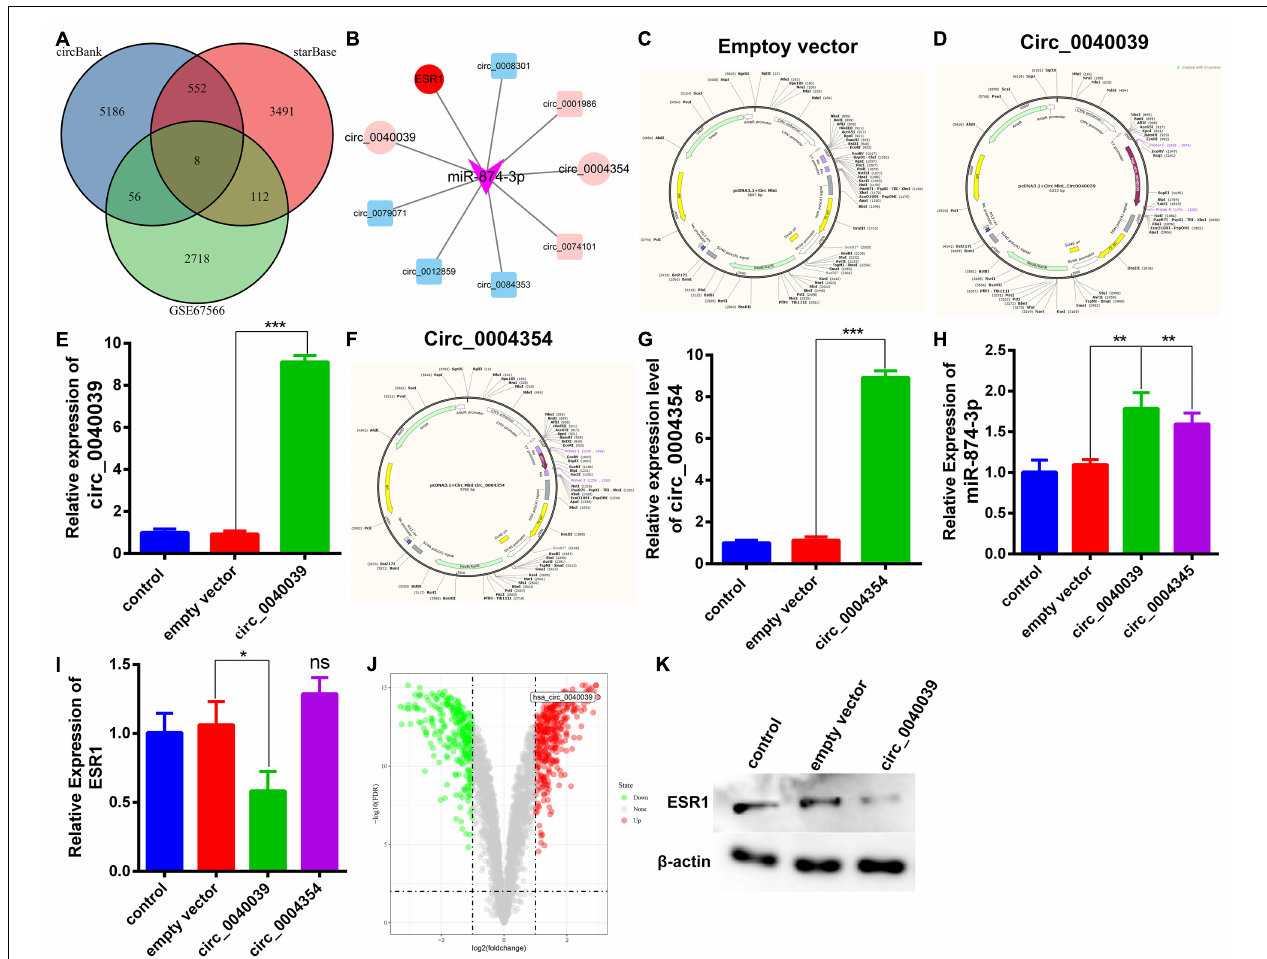
FIGURE 4 | Prediction and verification of the upstream circRNAs of miR-874-3p. (A) Venn diagram was used to select the overlapping upstream circRNAs of miR-874-3p through the intersection of circbank and starBase databases, and the GSE67566 dataset. (B) CircRNAs-miR-874-3p-ESR1 interaction network was established using Cytoscape software. Light red represents upregulated circRNAs, and light green represents downregulated circRNAs. Circ_0040039, circ_0004354, and ESR1 were exhibited with a red ellipse, whereas miR-874-3p was represented by purple triangles. (C) CircRNA empty vector atlas. (D) Circ_0040039 overexpression vector atlas. (E) Overexpression effect of circ_0040039 was validated in NPCs using the qRT-PCR assay. (F) Circ_0004354 overexpression vector atlas. (G) qRT-PCR assay corroborated that the expression of circ_0004354 significantly increased in circ_0004354-transfected NPCs. (H) qRT-PCR assay confirmed that the expression level of miR-874-3p was elevated in NPCs after transfection with circ_0040039 or circ_0004354. (I) ESR1 expression level was measured in NPCs after transfection with circ_0040039 or circ_0004354 or corresponding NC using the qRT-PCR assay. (J) Volcano plot shows the predicted circ_0040039 based on the analysis of GSE67566. Green points represent downregulated circRNAs (left side), and red points represent upregulated circRNAs (right side); circ_0040039 is presented. (K) Western blotting assay demonstrated that circ_0040039 inhibits the protein expression level of ESR1. Data are represented as the mean ± SD. * P < 0.05, ** P < 0.01, *** P <